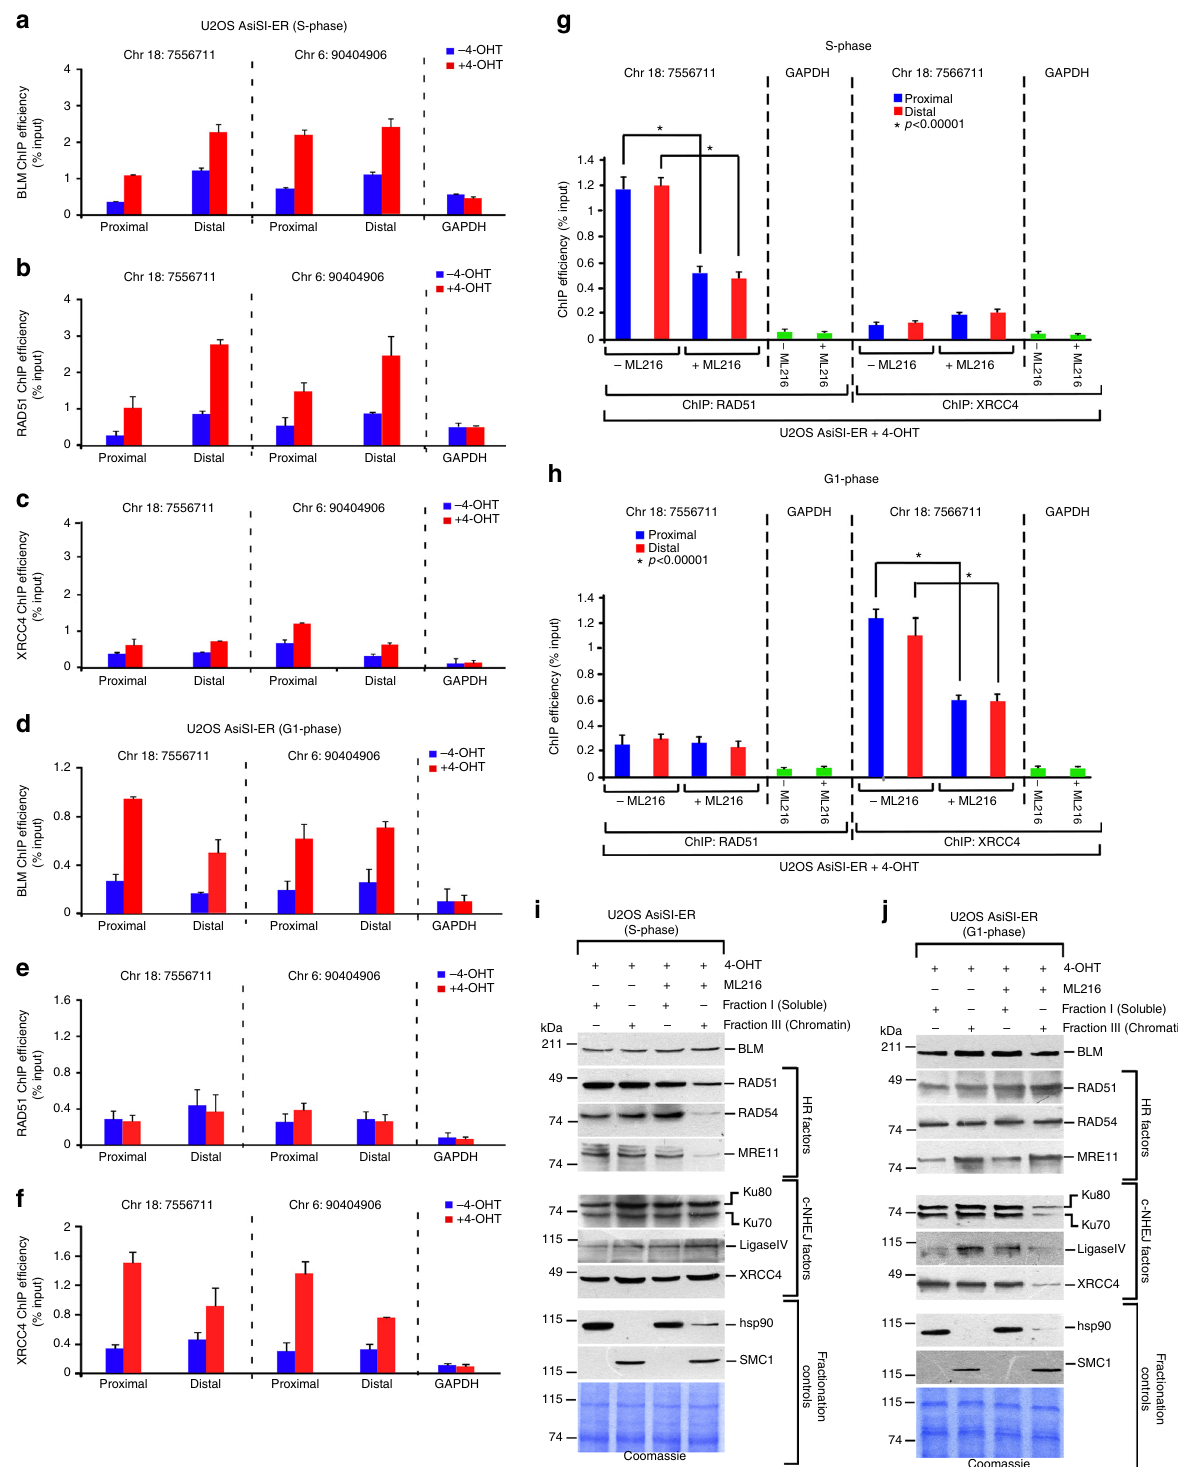
ProximalDistal Distal